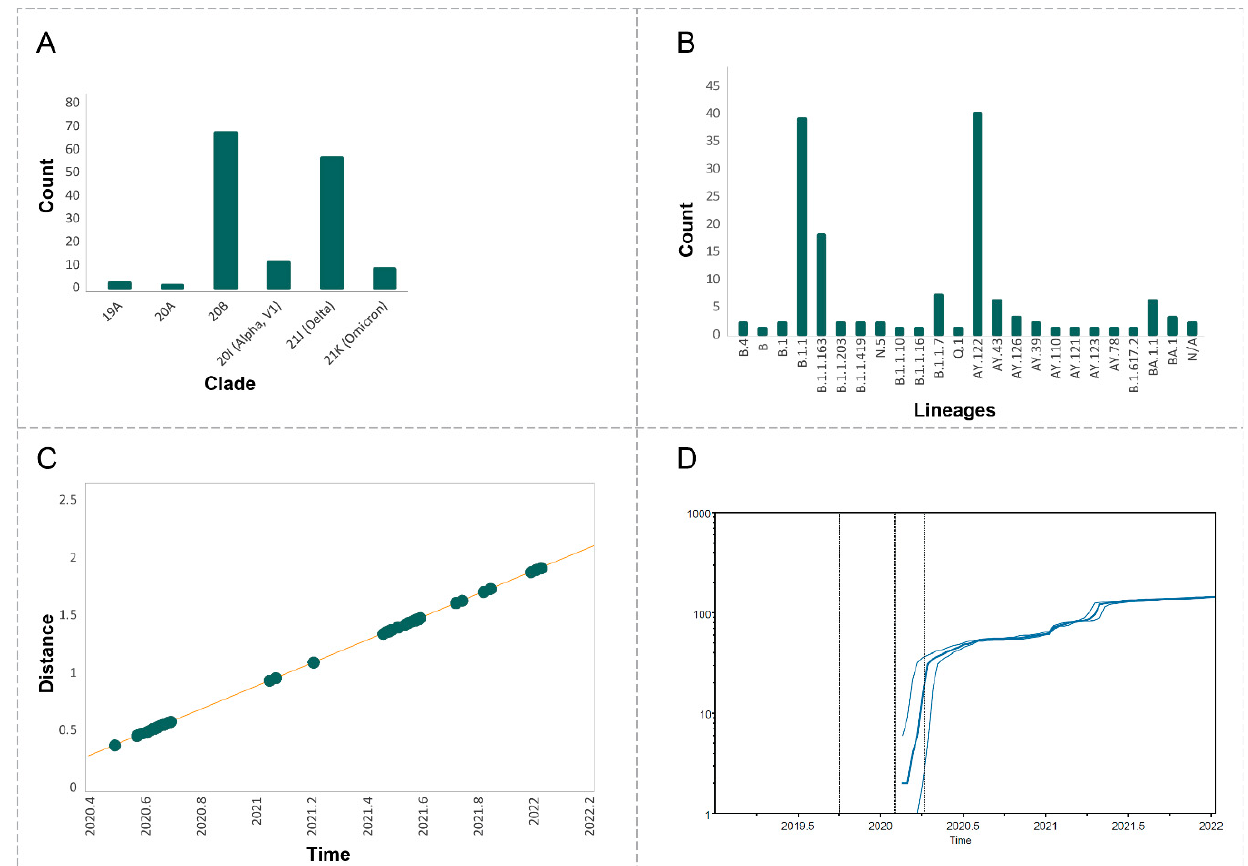
Figure 2. ( A ) Distribution of SARS-CoV-2 lineages according to Nextstrain clade nomenclature. ( B ) Distribution of SARS-CoV-2 lineages according to PANGO lineages nomenclature. ( C ) Root-to-tip regression analyses using TempEst. The plot represents linear regression of root-to-tip genetic distance within the ML phylogeny against sampling time. ( D ) “Lineage through time” plot of the phylogenetic tree of Armenian samples. The solid thick line represents the log median of ancestral lineages present at each time interval. Thin lines represent 95% confidence intervals for the number of lineages.